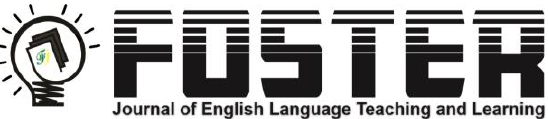
Table 4.1 The Score of college Pre-test Result in Experimental